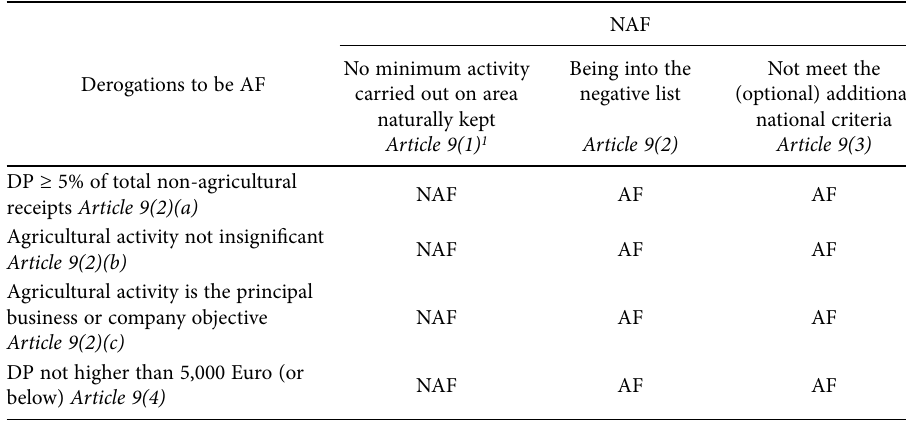
Table 1. “Active farmer”: provisions and derogations.